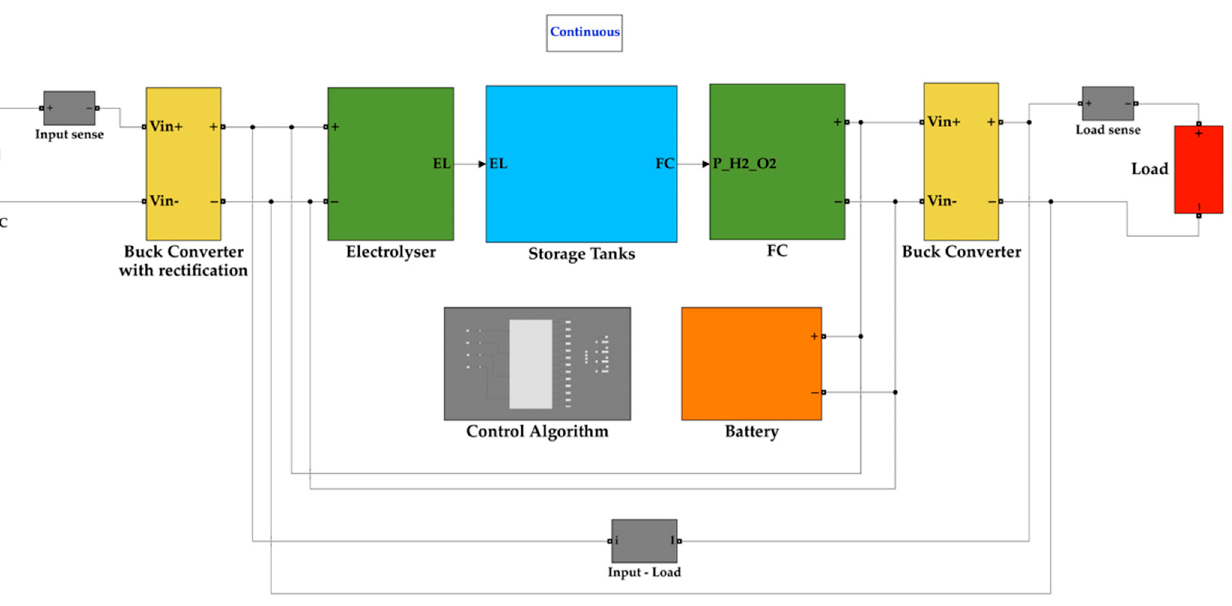
Figure 5. Simulink model of the proposed system.